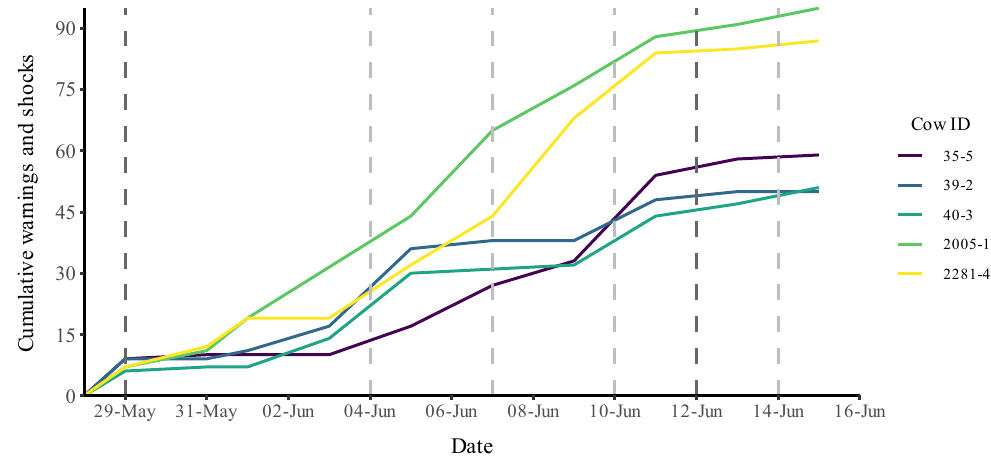
Figure 3. Cumulative auditory warnings and electric impulses during the study period of 29 May to 15 June 2021 where manure was collected from five animals for cortisol analyses. The virtual training started on 29 May; from 12 June onward, the fence was solely virtual. The vertical plot lines in represent significant changes in the virtual boundaries, with the darker lines indicating the beginning (29 May) and end (12 June) of the virtual training period.